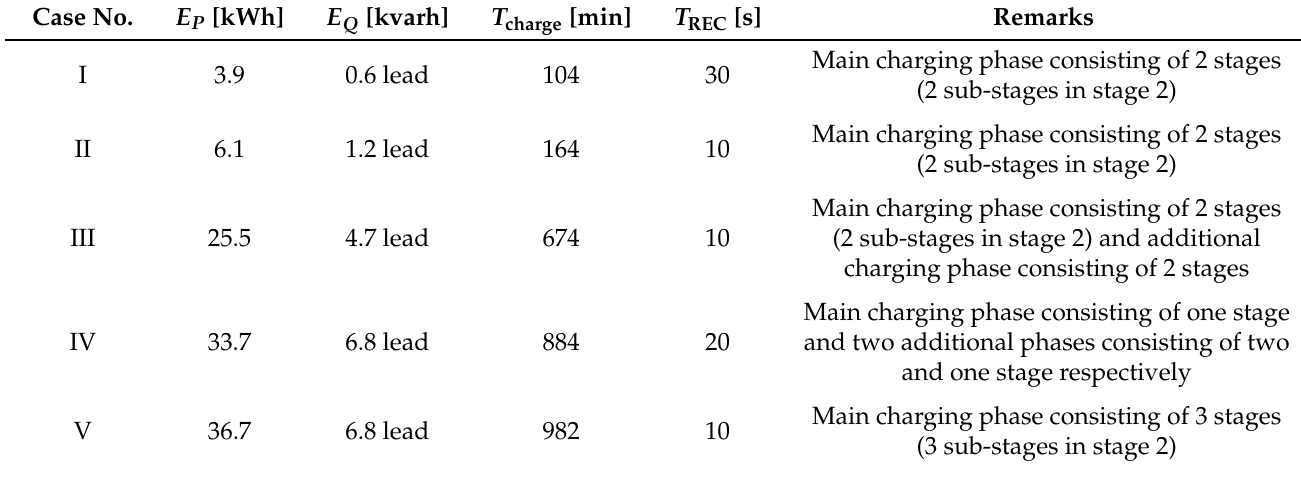
Table 1. Summary of the selected charging